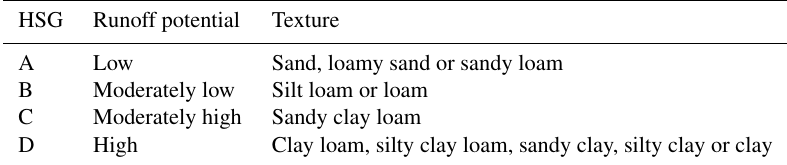
Table A3. Hydrological Soil Groups